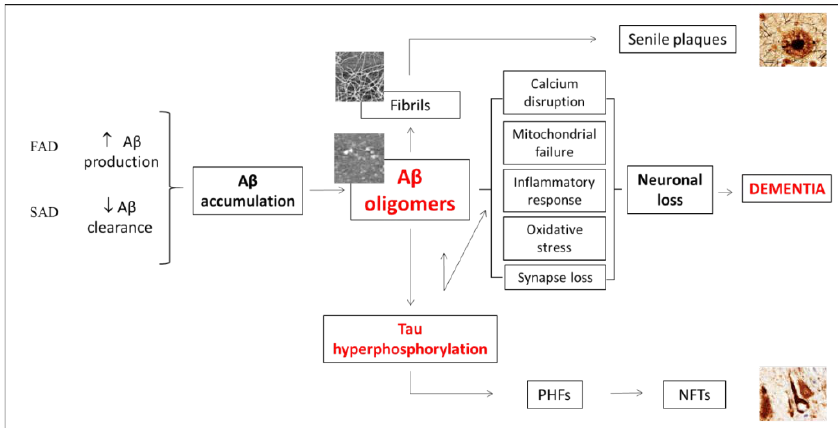
Figure 8. Putative mechanism of the e ff ect of A β immunotherapy on cognition. The amyloid cascade hypothesis states that the accumulation of A β oligomers is toxic for neurons through two mechanisms, directly and by inducing tau hyperphosphorylation and aggregation. Tau aggregates, in turn, induce A β oligomerization, which leads to a positive feedback that potentiates the amyloid pathway and eventually results in neuronal loss and dementia. Thus, capturing A β oligomers prevents neuronal loss and the subsequent dementia. FAD: Familial AD. SAD; Sporadic AD. PHF: Paired helical filaments. NTFs: neurofibrillary tangles.